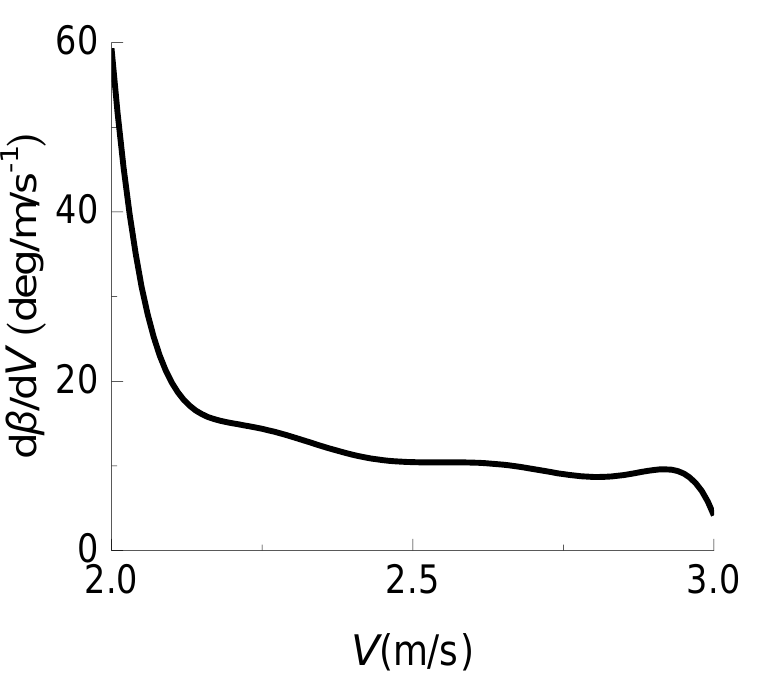
Figure 11. Rate of the optimal pitch angle relative to the tidal velocity. When the flow velocity exceeds 2.4 m/s, the d β /d V curve is close to a horizontal line, which shows that under this condition, the pitch angle needs to be adjusted in a very small step according to the change in the tidal velocity to meet the requirements of power limitation. This corresponds to increased requirements for the servo system. In order to improve the robustness of the pitch angle servo adjustment system, the upper limit of the power-limited working range is set to a flow velocity of 2.4 m/s, and the corresponding optimal pitch angle is approximately 8 ◦